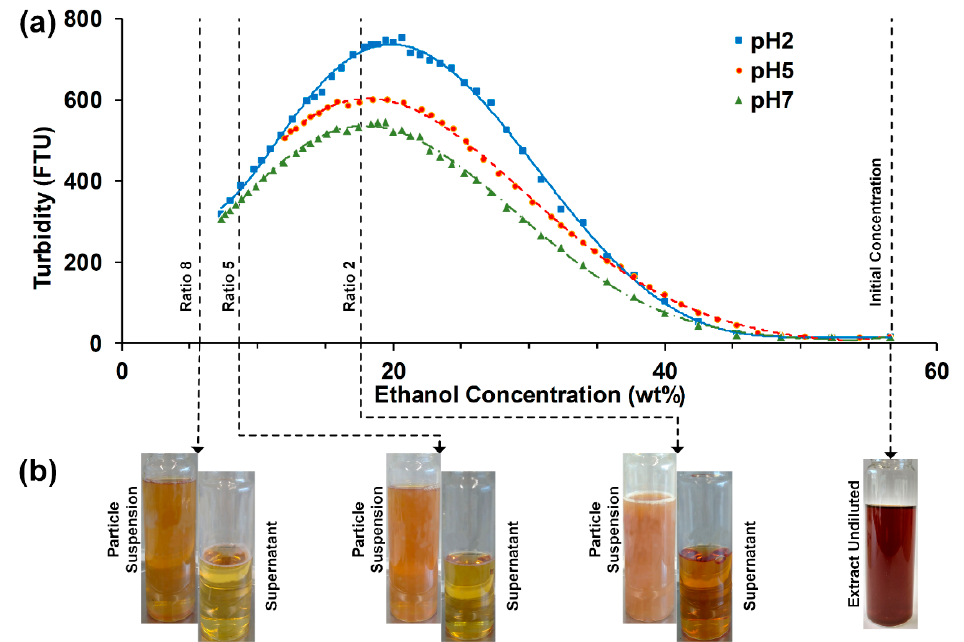
Figure 1. ( a ) Turbidity against ethanol concentration in solution/suspension. The ethanol concentration was gradually lowered by adding antisolvent at different pH values to the organosolv extract in a stirred vessel. ( b ) Pictures of particle suspensions and supernatants after centrifugation originate from precipitations in the static mixer with pH 5 antisolvent and a flowrate of 112.5 mL/min.